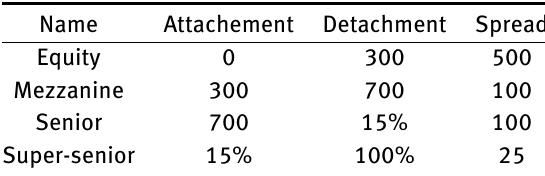
Table 1: Structure and summary statistics on CDX.NA.IG.21 tranches.